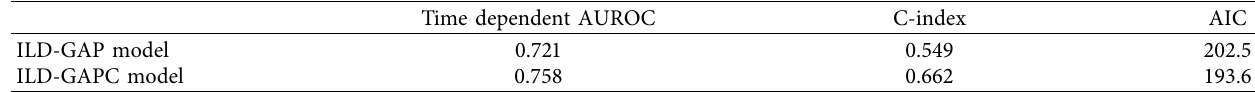
(Figure 3(d)), unlike ILD-GAP scores ( P � 0 . 074) (Figure 3(c)).